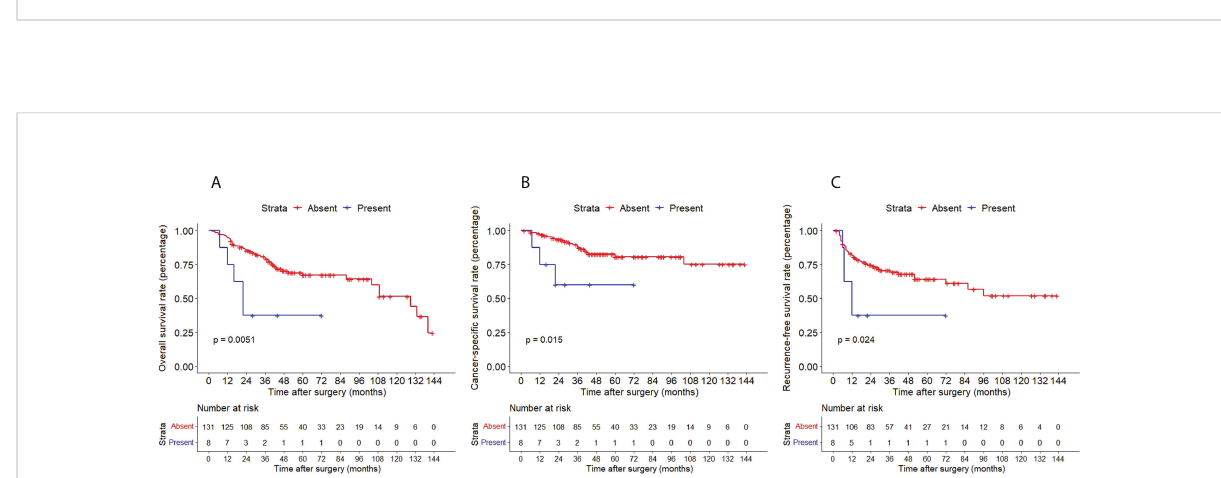
FIGURE 5 Kaplan – Meier curves for OS (A) , CSS (B) and RFS (C) of patients with UTUC according to adjuvant chemotherapy. OS, overall survival; CSS, cancer-speci fi c survival; UTUC, upper tract urothelial carcinoma; IVR, intravesical recurrence.